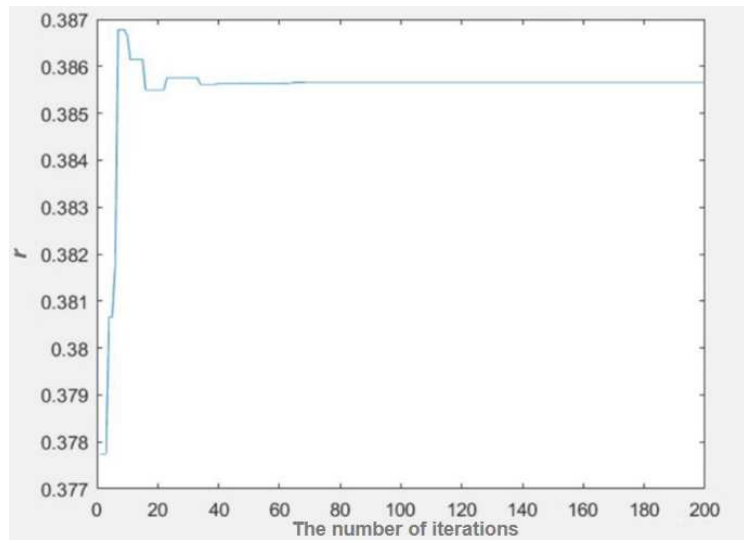
Figure 2. The convergence process of r.